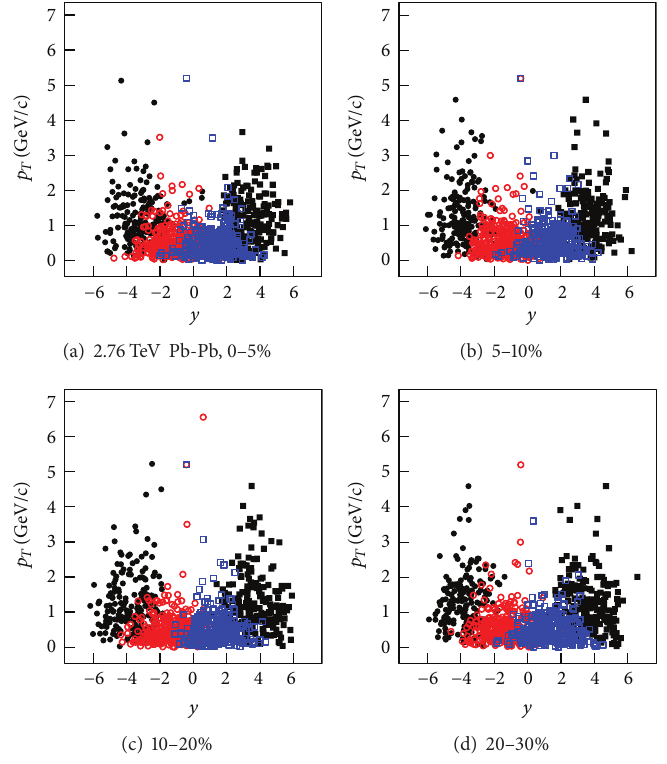
Figure 10: The same as for Figure 4, but showing the results in the space 𝑝 𝑇 − 𝑦